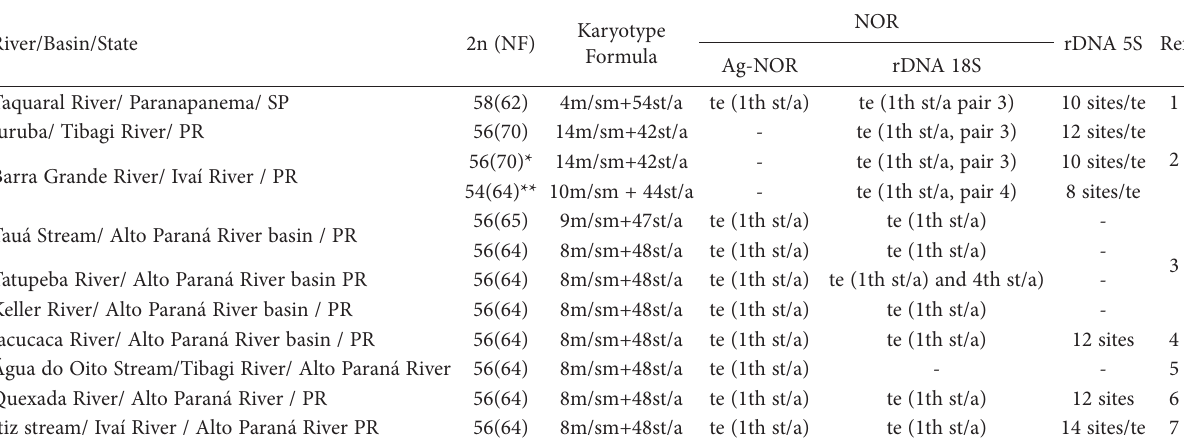
Table 1. Cytogenetic data available for Rineloricaria pentamaculata.